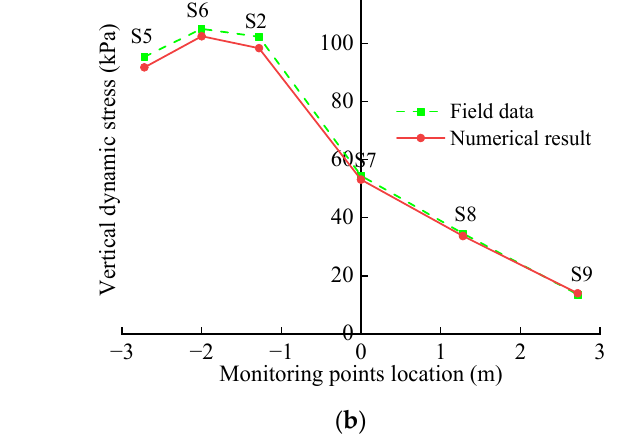
Figure 8. Comparison of dynamic field test and numerical simulation results: ( a ) Vertical attenuation contrast; ( b ) Horizontal distribution comparison.